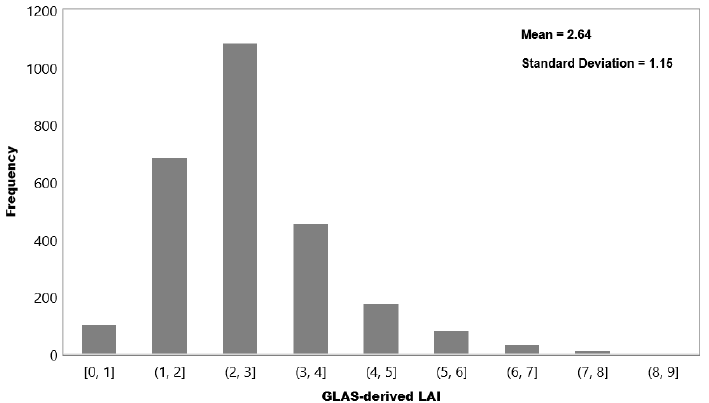
Figure 11. Evaluation of LAI variation in 10 years using Moderate Resolution Imaging Spectroradiometer (MODIS) LAI product. ( a ) is the column plot displaying the variation between MODIS LAI of 2018 and 2006. ( b ) is the scatter plot displaying the correlation between MODIS LAI of 2018 and 2006.